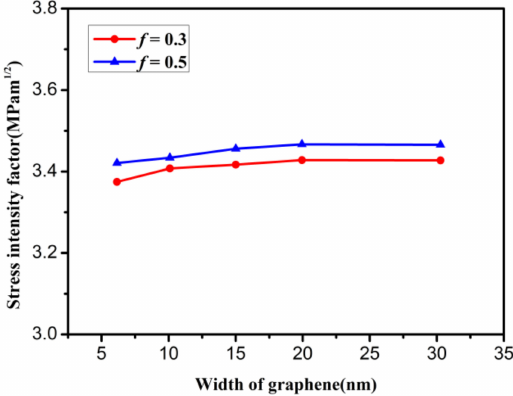
Figure 9. The variation in stress intensity factor with increasing graphene